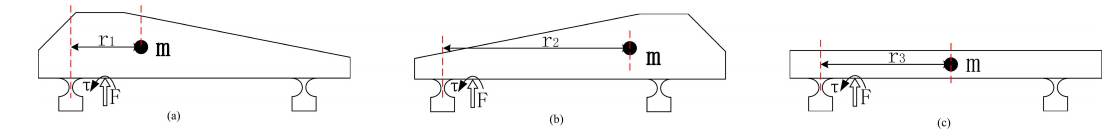
Figure 4. The lever amplification mechanism with different geometric